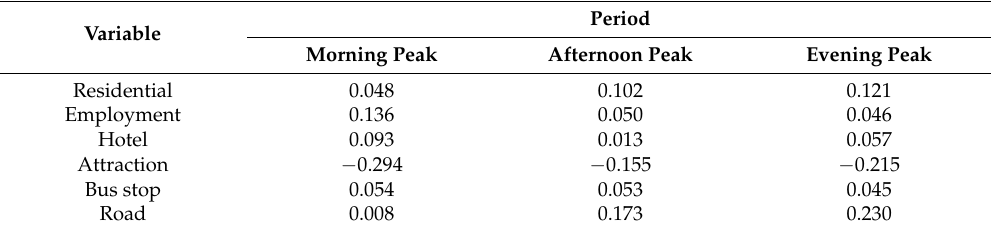
Table 7. Average coefficients across the different peak periods.